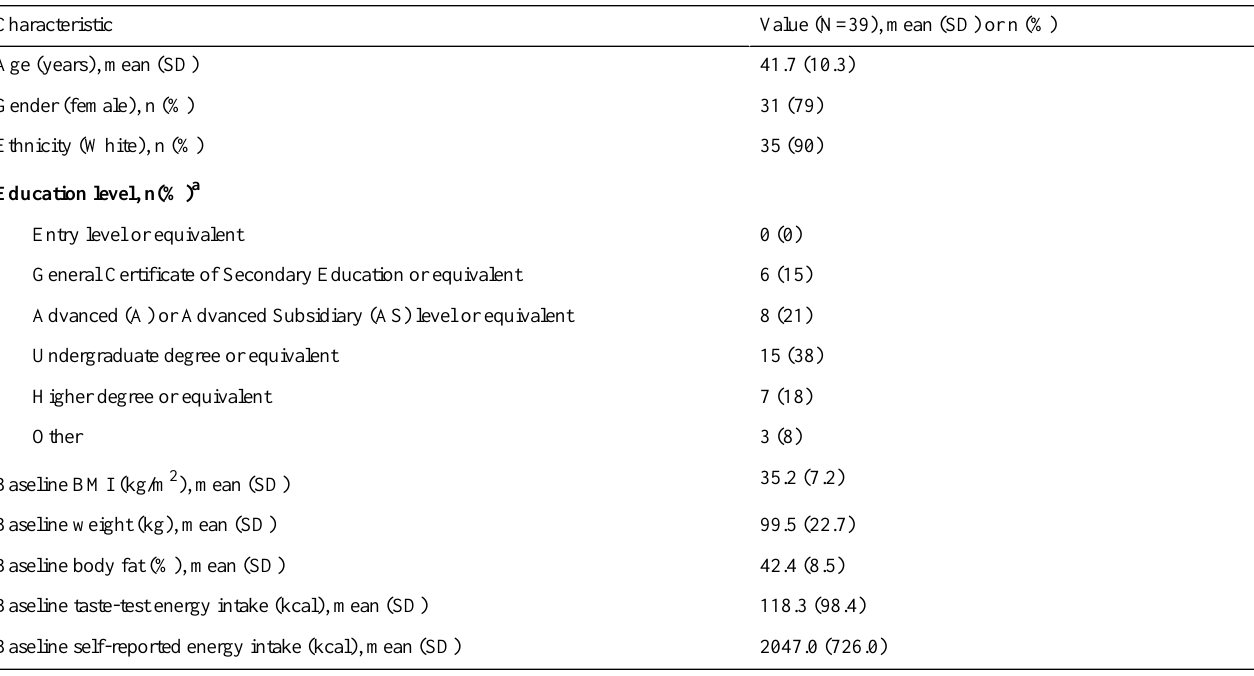
Table 1. Baseline characteristics of the analyzed sample.